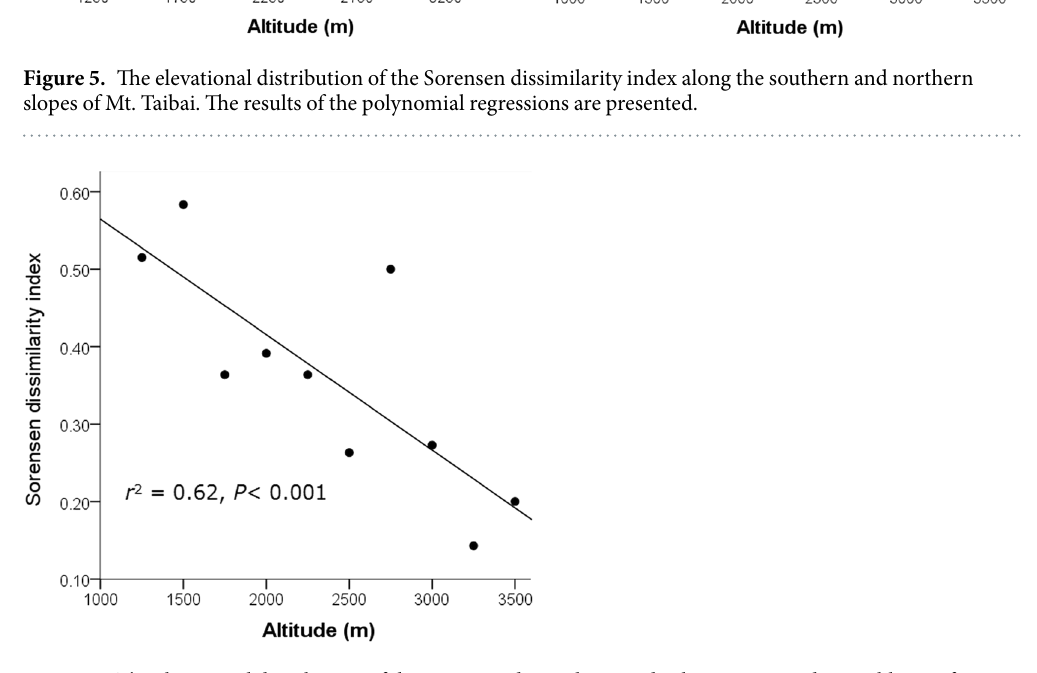
Figure 6. The elevational distribution of the Sorensen dissimilarity index between paired assemblages of similar elevation on the southern and northern slopes of Mt. Taibai. The results of the linear regression are